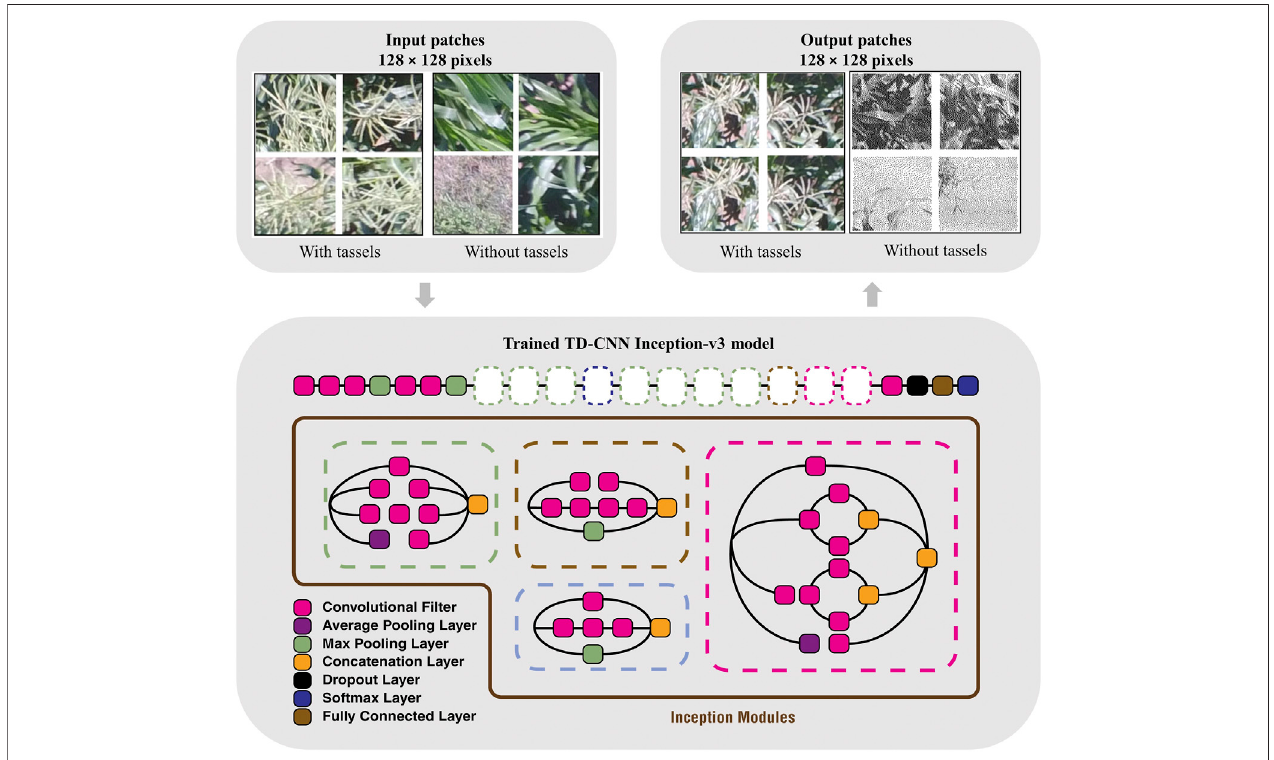
FIGURE 3 | [Best viewed in color] Tassel detection with TD-CNN trained with the Inception v3 model.